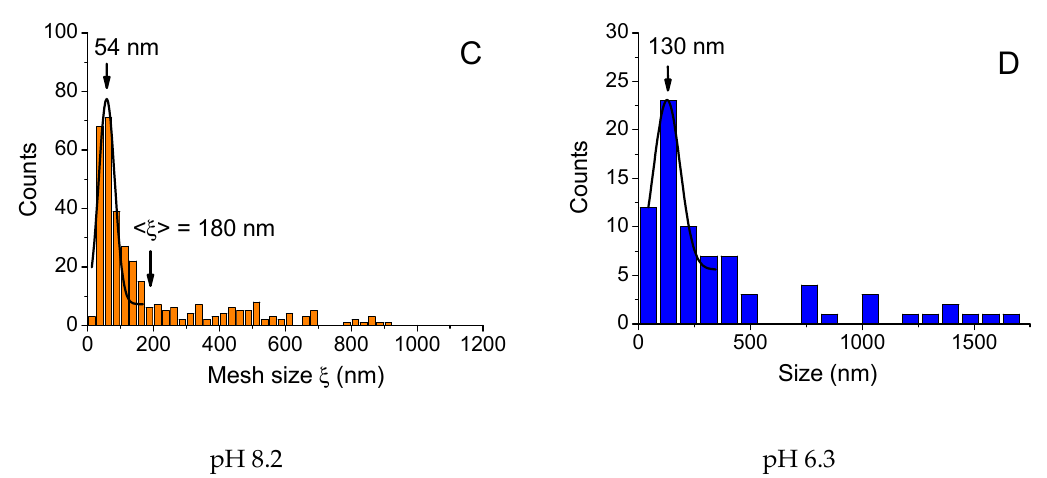
Figure 6. Distributions of sizes of objects ( A , D ) and mesh sizes of the network ( B , C ) obtained from FF-TEM micrographs for 0.1 wt % xanthan aqueous solutions in the presence of 0.017 wt % CrCl 3 (molar ratio [CrCl 3 ]/[xanthan monomer units] = 1) prepared at different pH: 1.5 ( A ), 2.4 ( B ), 6.3 ( C ) and 8.2 ( D ) at 20 °C. 3.3. Change of pH after Preparation